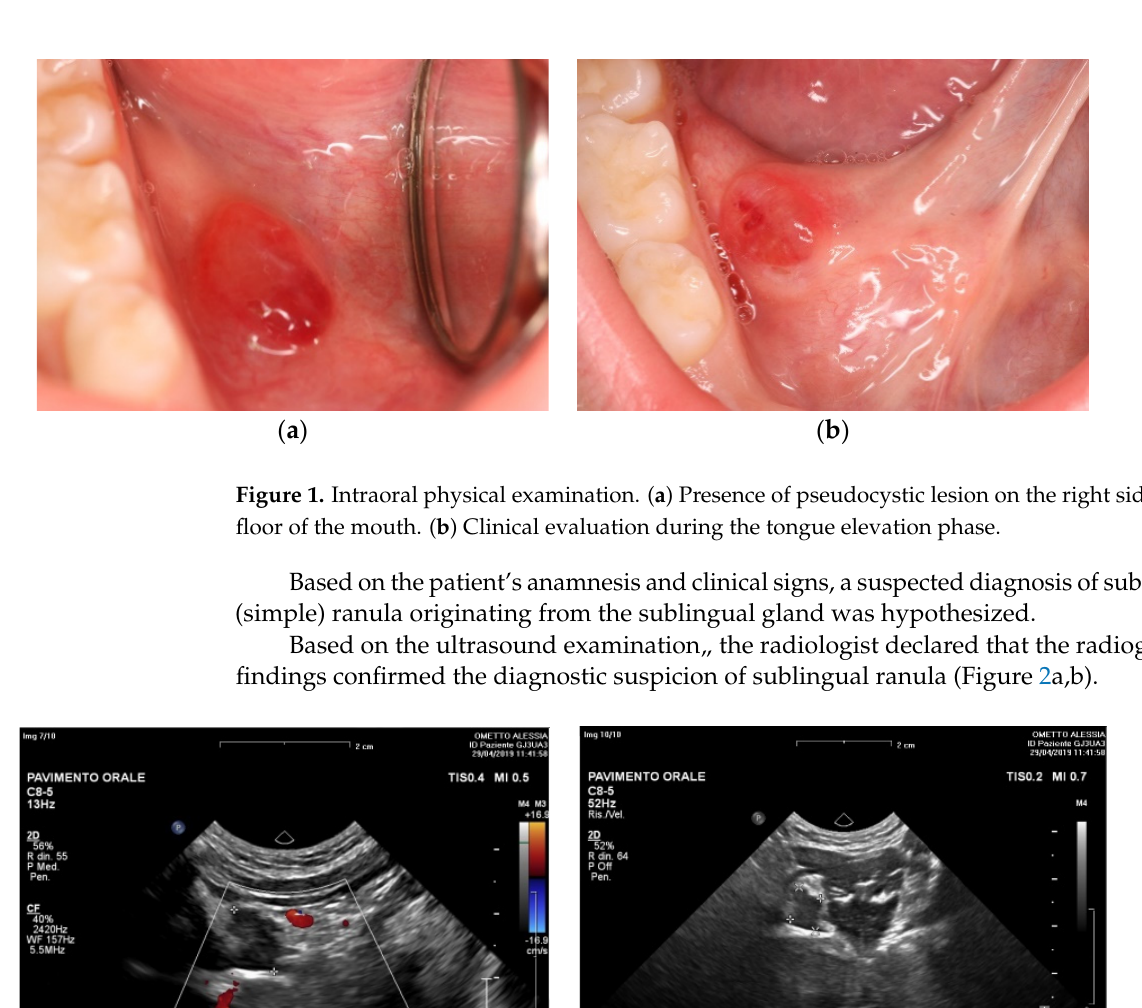
Figure 1. Intraoral physical examination. ( a ) Presence of pseudocystic lesion on the right side of the floor of the mouth. ( b ) Clinical evaluation during the tongue elevation phase.